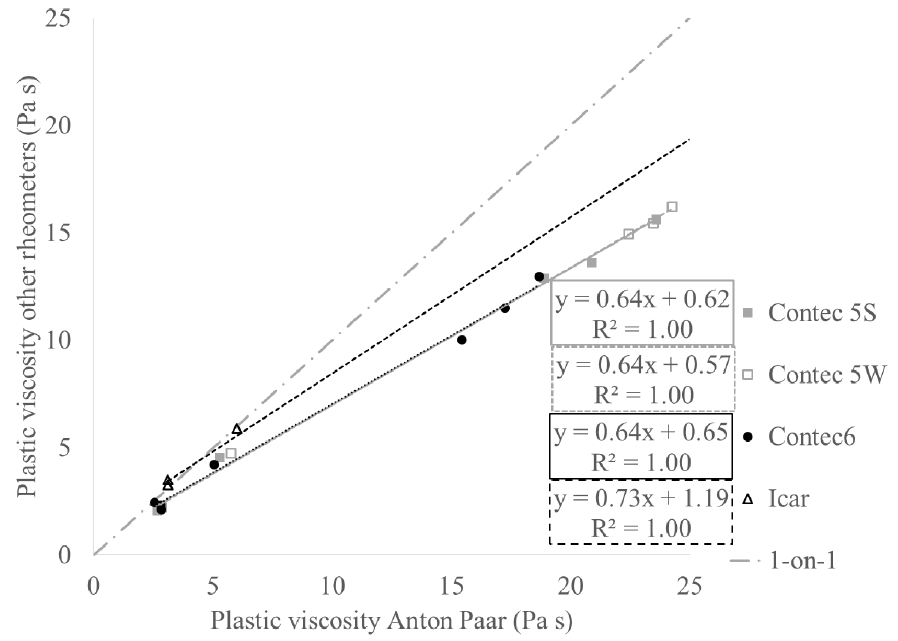
Figure 3. Comparing of the plastic viscosity values between all rheometers and the Anton Paar.